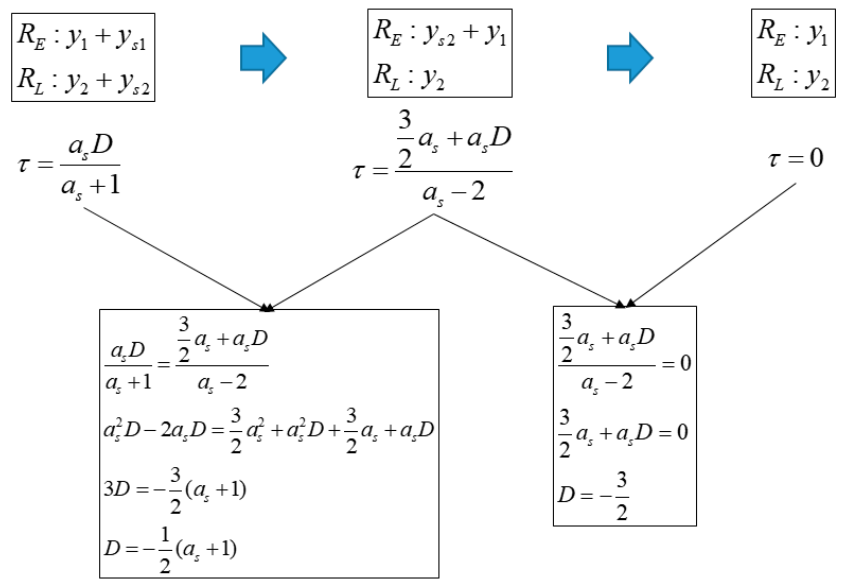
τ Figure 11. Equation of and D in case that the spoofing signal strength is lower than authentic Figure 11. Equation of τ and D in case that the spoofing signal strength is lower than authentic signal signal and XE is same with XL . and XE is same with XL